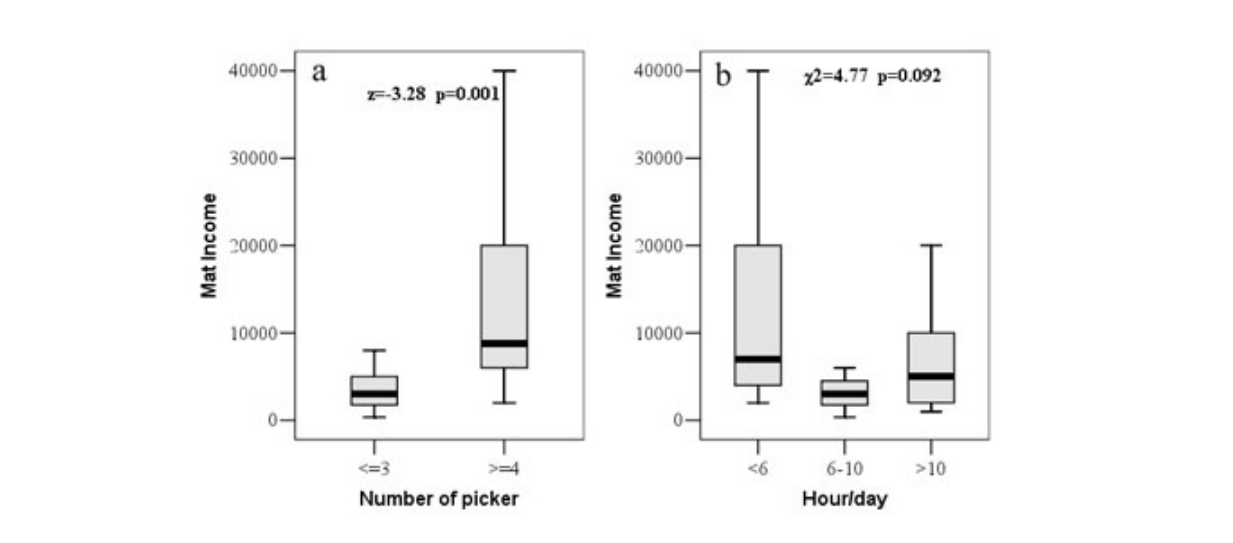
Fig. 6. Box plot showing labor input related to income